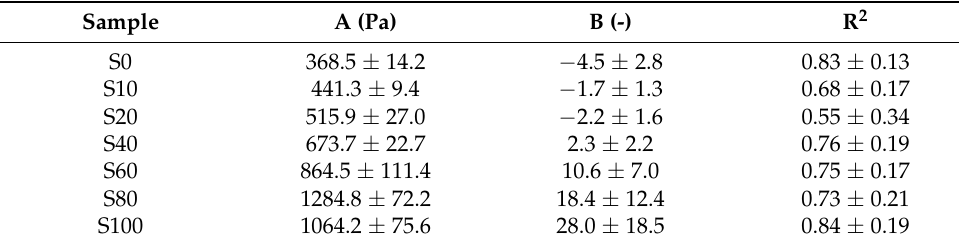
Table 5. Parameters of the Weltman model.